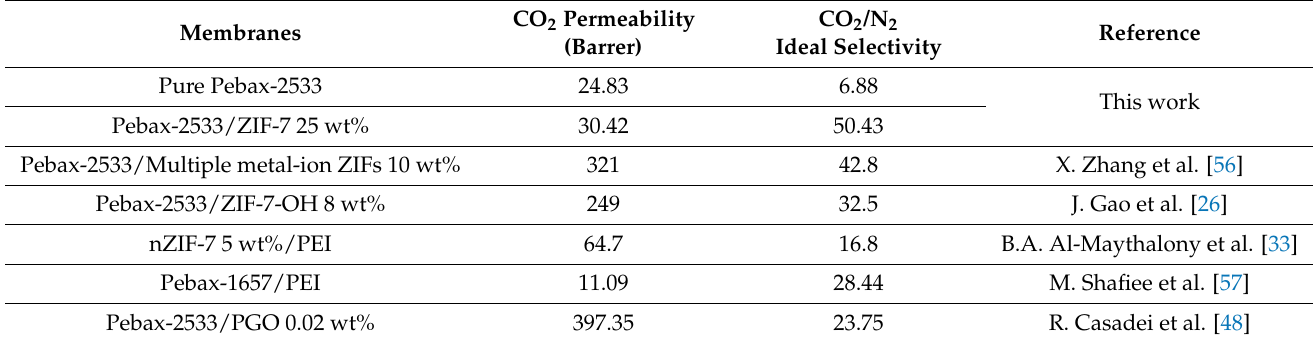
Table 8. Gas permeation properties in various membranes with this